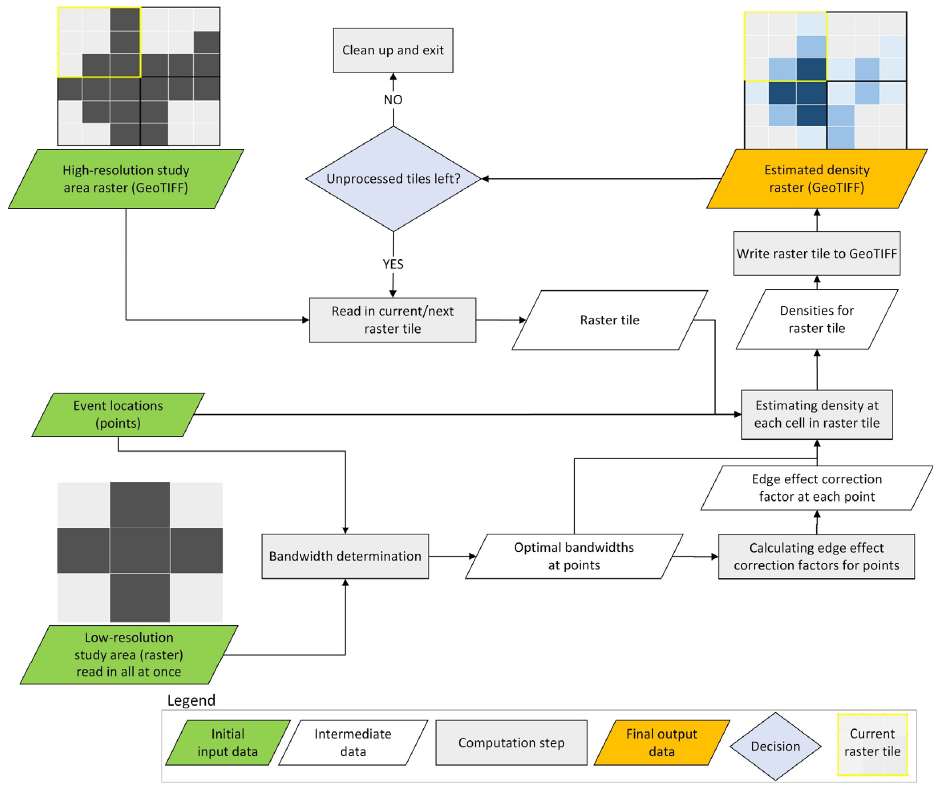
Figure 4. The extended GPU-parallel KDE algorithm estimates density raster one tile at a time.